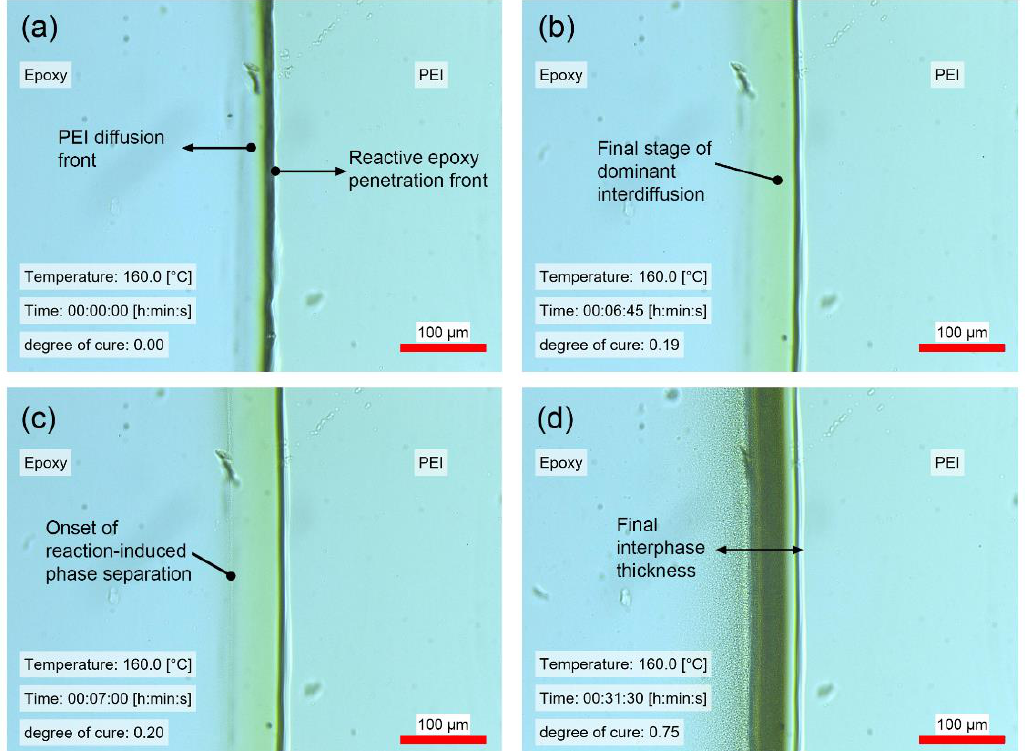
Figure 6. Reactive multicomponent diffusion experiment with the epoxy system at 160 °C: ( a ) start of partial dissolution; ( b ) end of diffusion; ( c ) initiation of reaction-induced phase separation; ( d ) end of phase separation with visible decomposed microstructure.